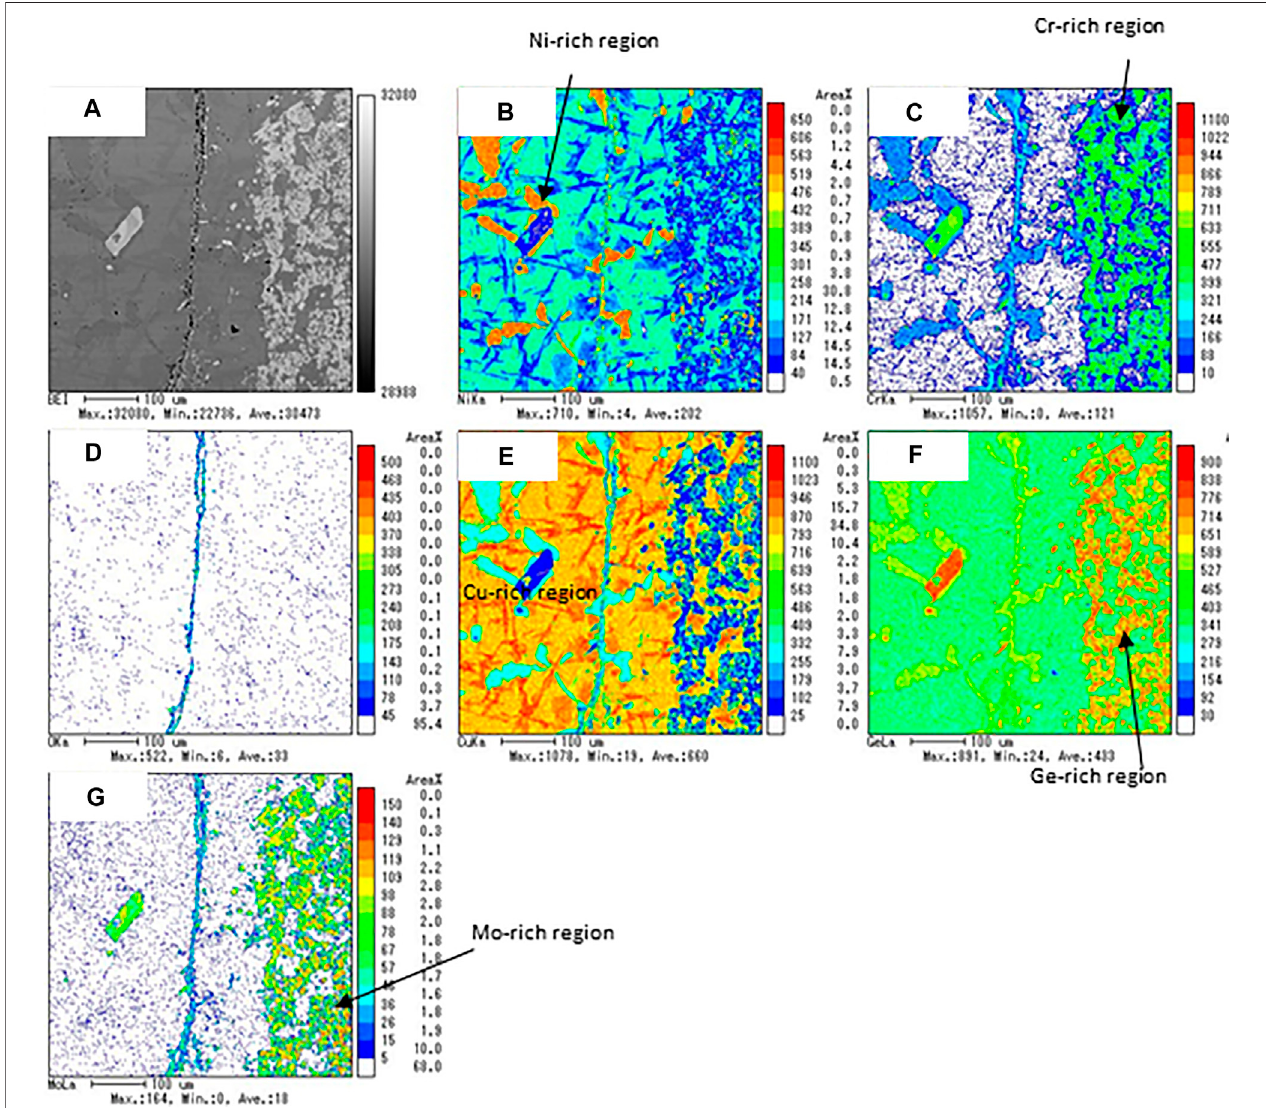
FIGURE10| TheresultsoftheEPMAanalysisforthechemicalcompatibilitytestofInconel625/CuGe40. (A) BEIimage, (B) Ni, (C) Cr, (D) O, (E) Cu, (F) Ge,and (G) Mo mapping images.